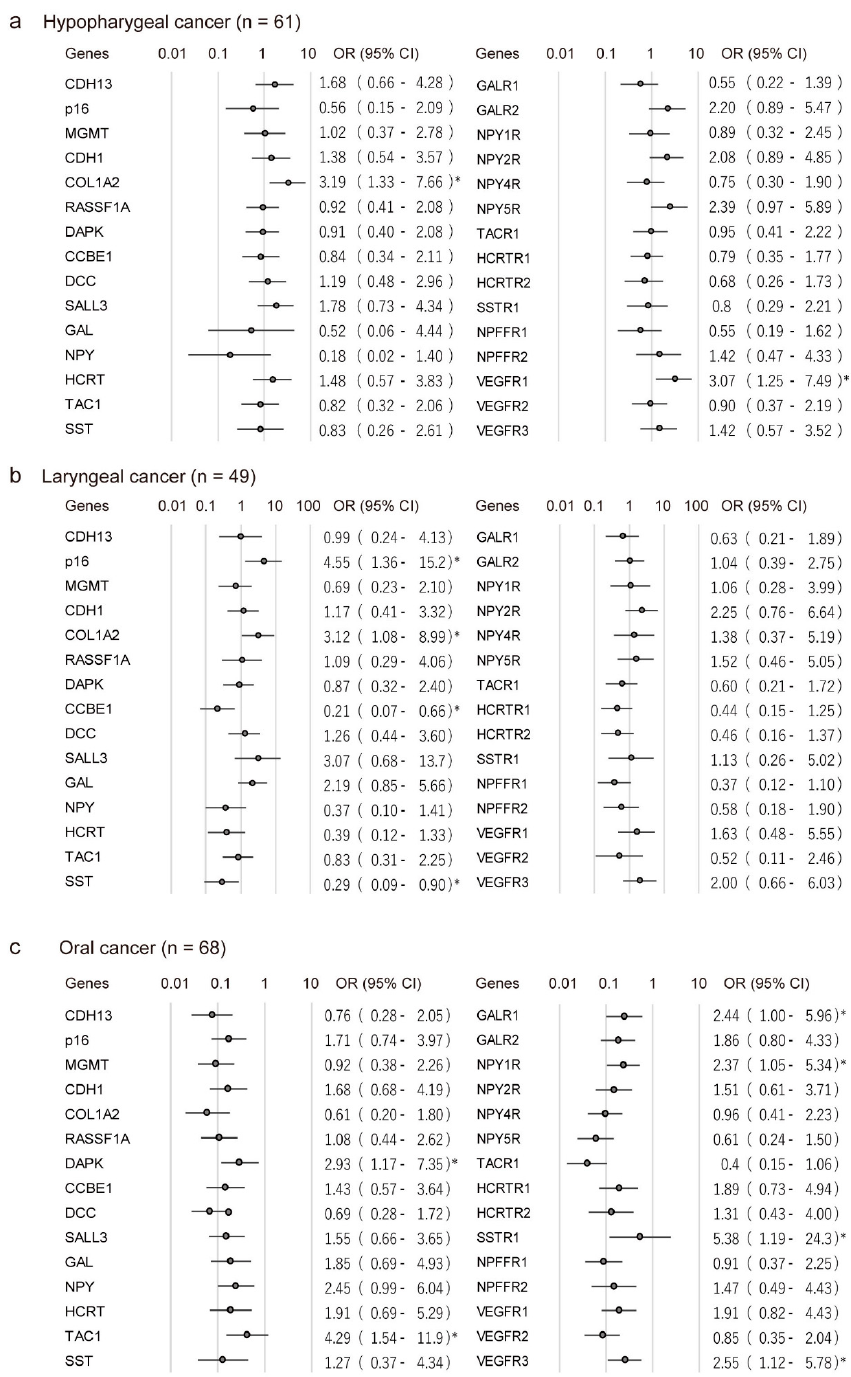
Figure 3. Odds ratios (ORs) for recurrence of cancers. Shown are the ORs of recurrence associated with methylation of different tumor-related genes (TRGs) in ( A ) hypopharyngeal cancer; ( B ) laryngeal cancer; and ( C ) oral cancer. ORs were calculated based on the Cox proportional hazards model, adjusted for age ( ≥ 70 years vs. <70 years), sex, alcohol exposure, smoking status, and tumor stage (I and II vs. III and IV). CI: confidence interval. * p <